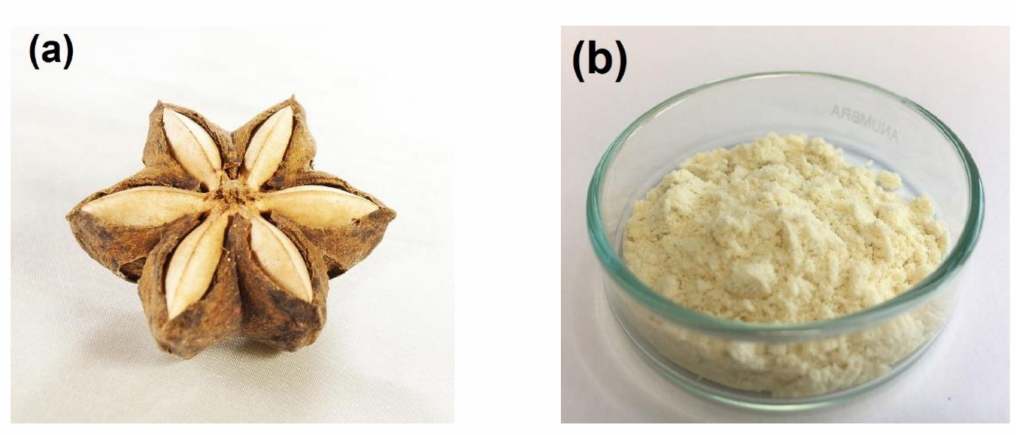
Figure 13. The physical appearance of ( a ) Sacha inchi seed and ( b ) the SI residues obtained after the oil extraction